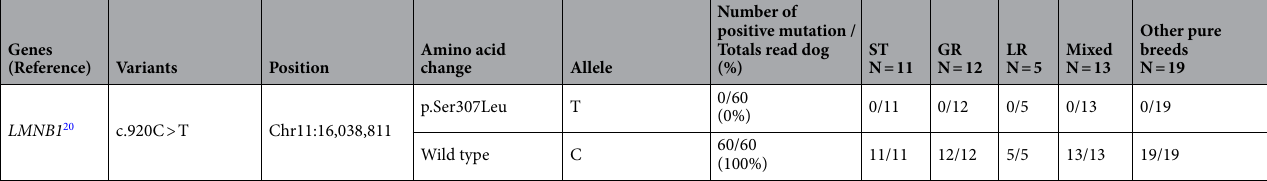
Table 2. The prevalence of 41 variant lists in 60 canine diffuse large B-cell lymphomas and dog breeds. Significant values are in bold. GR Golden retriever, LR Labrador retriever, ST Shih Tzu.